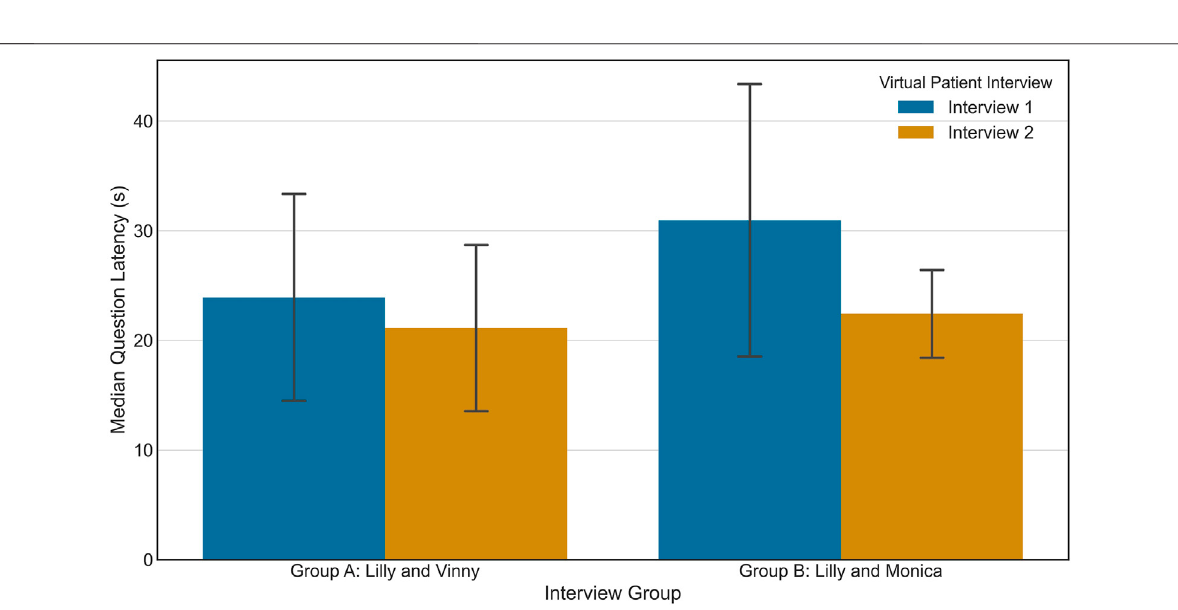
Frontiers in Virtual Reality |